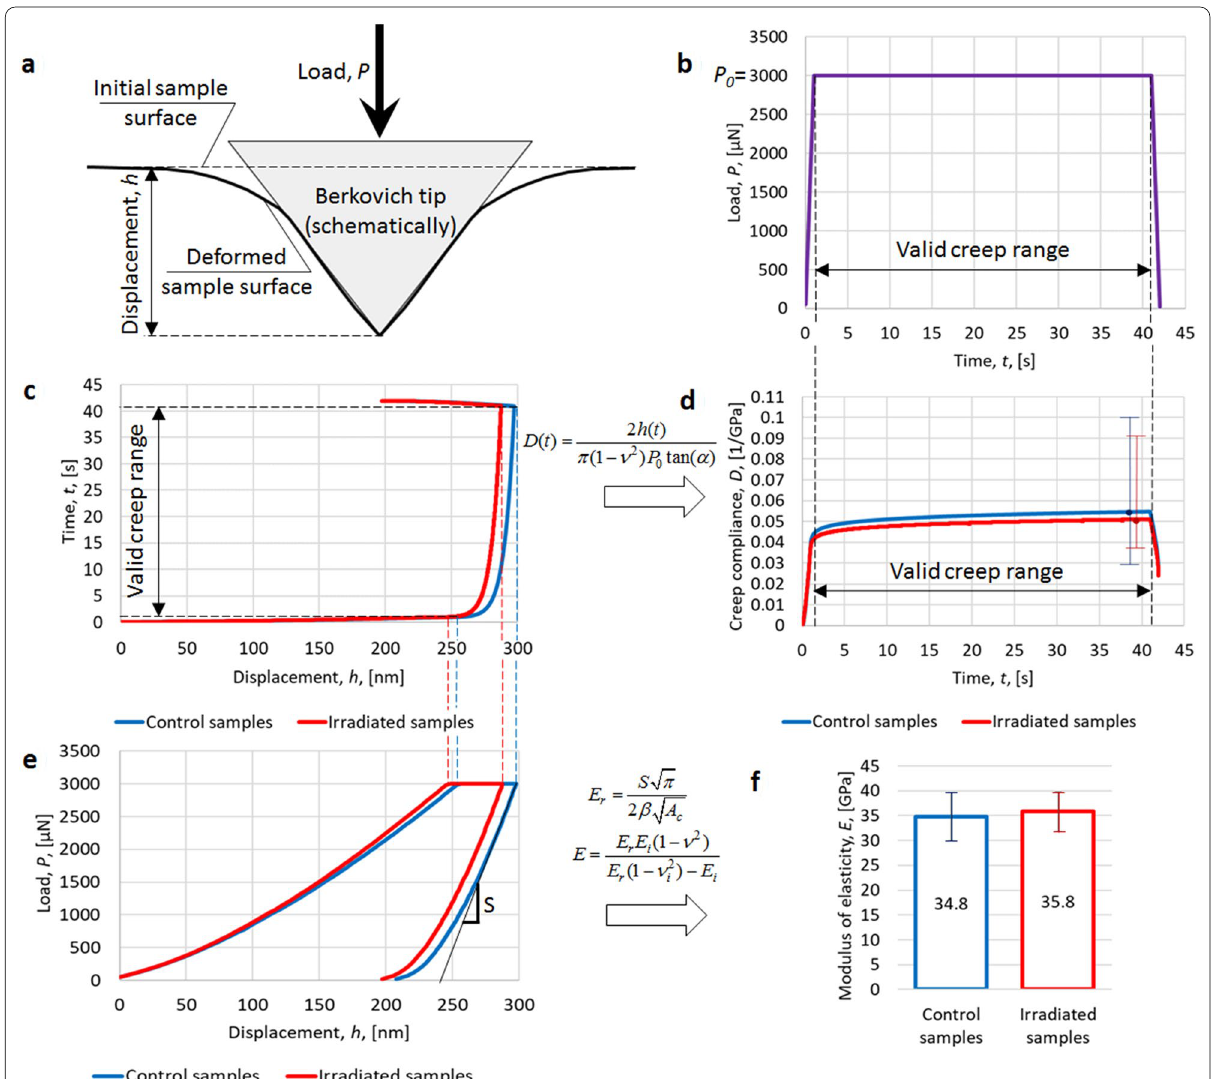
Fig. 6 Nanoindentation: a schematic description, b loading diagram, c average time–displacement curves of C–S–H gel, d average creep compliance of C–S–H gel, e average load–displacement curves of C–S–H gel, f average indentation elastic modulus of C–S–H